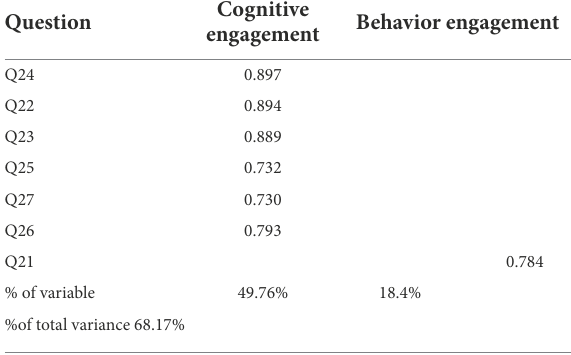
TABLE 2 Factor analysis of the self-efficacy scale in this study.